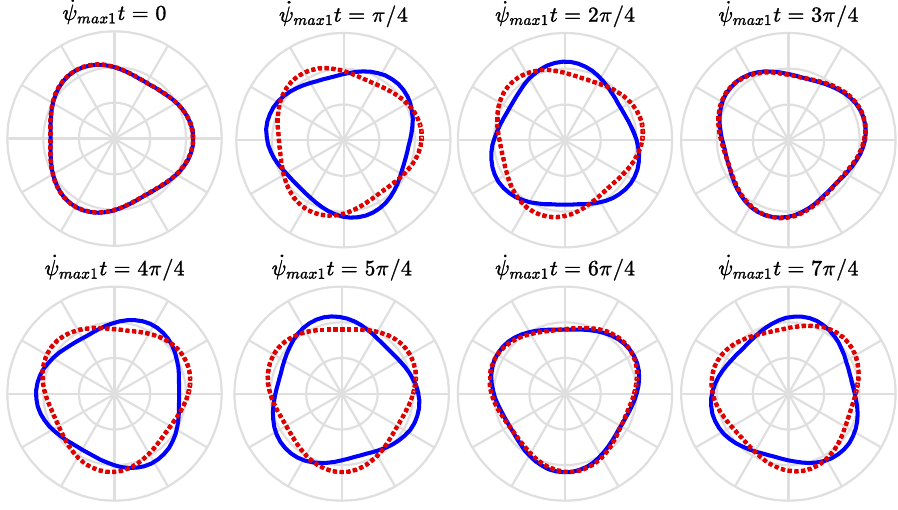
Figure 8. The traveling modes of n = 3 at various instance of time as viewed by a stationary observer.